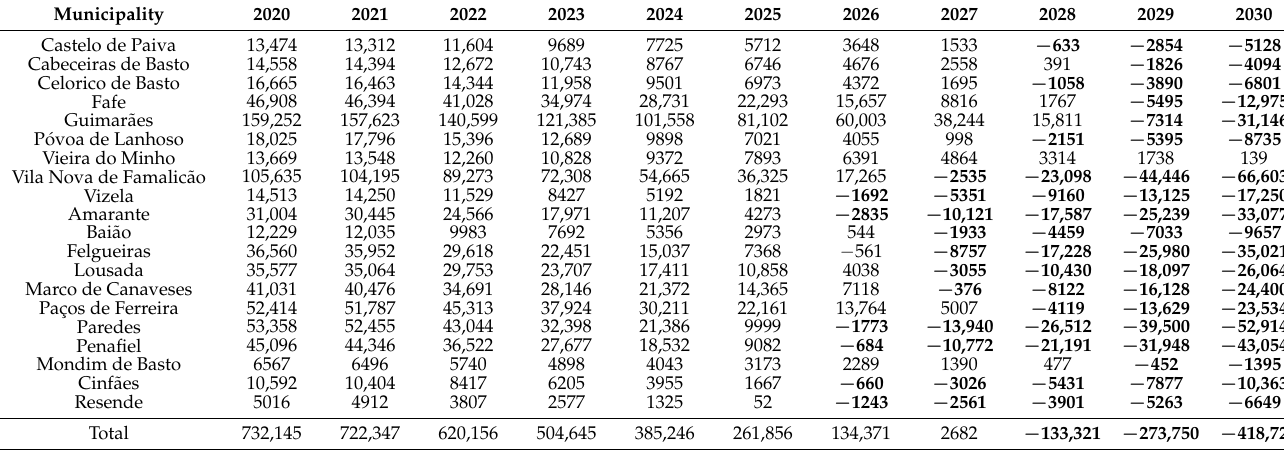
Table A6. Scenario 3: Impacts (available power–required power) of the BEV fleet on the grid during peak hours (values in kVA).